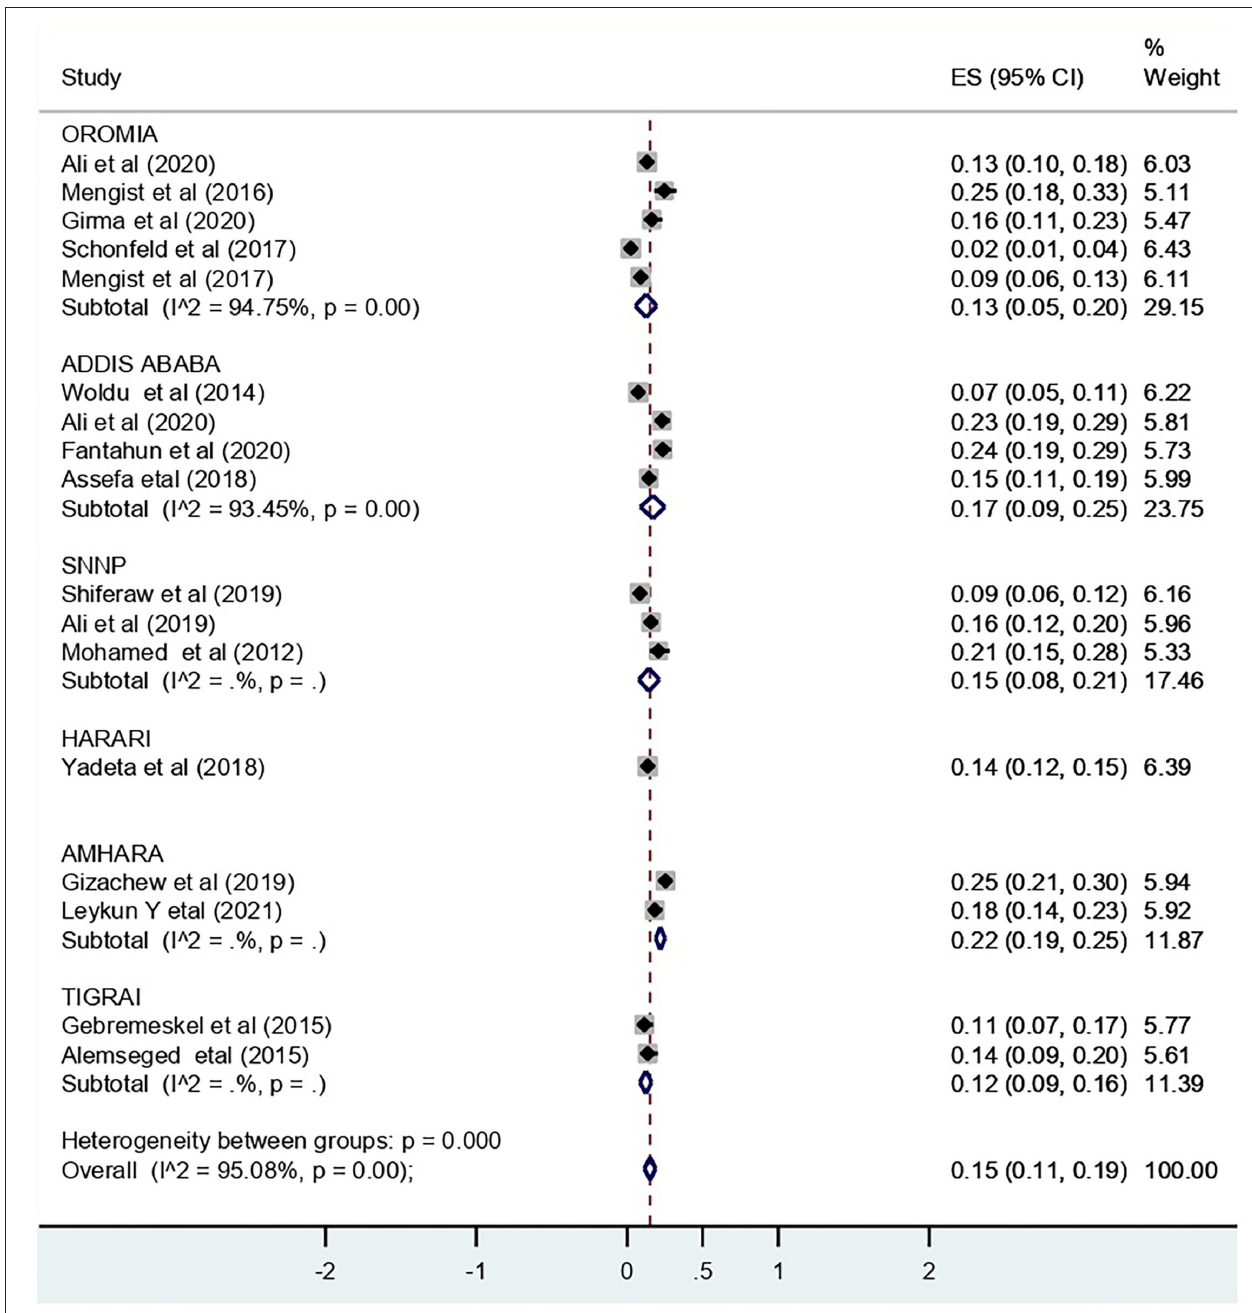
FIGURE 3 | Subgroup analysis by region for the pooled prevalence of RVC of GBS among pregnant women in Ethiopia, 2022.